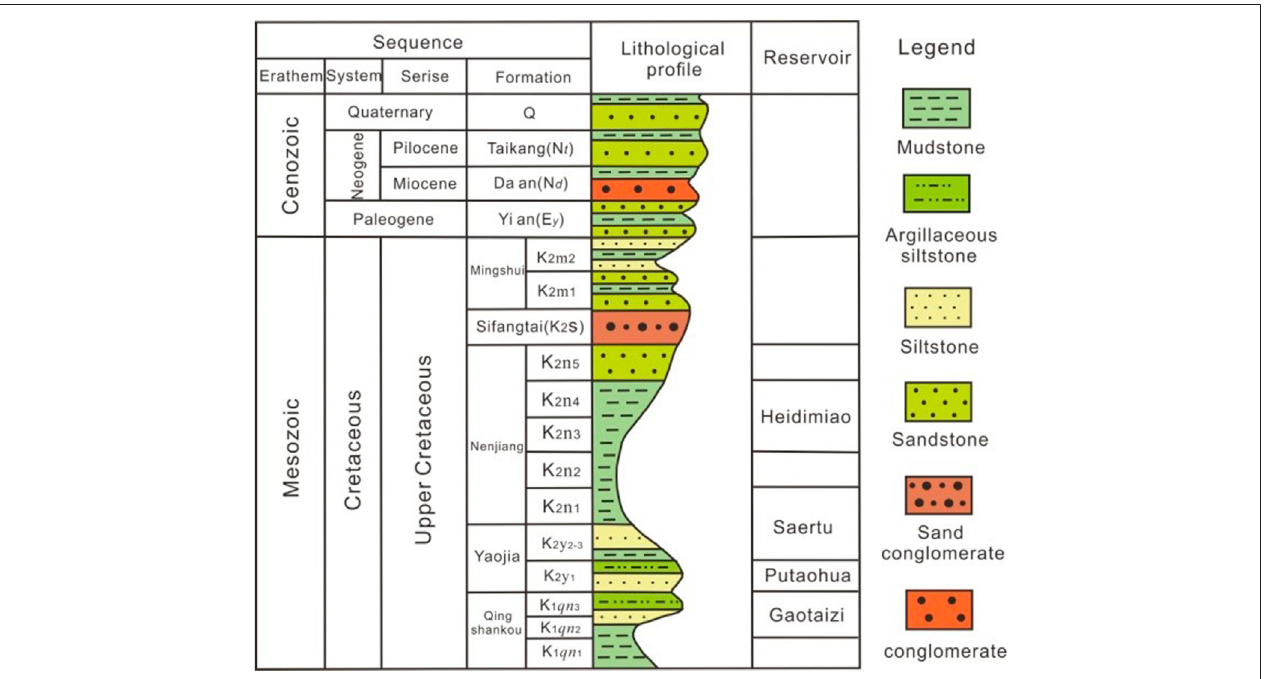
FIGURE 2 | Pro fi le map of the different reservoirs in the Naner